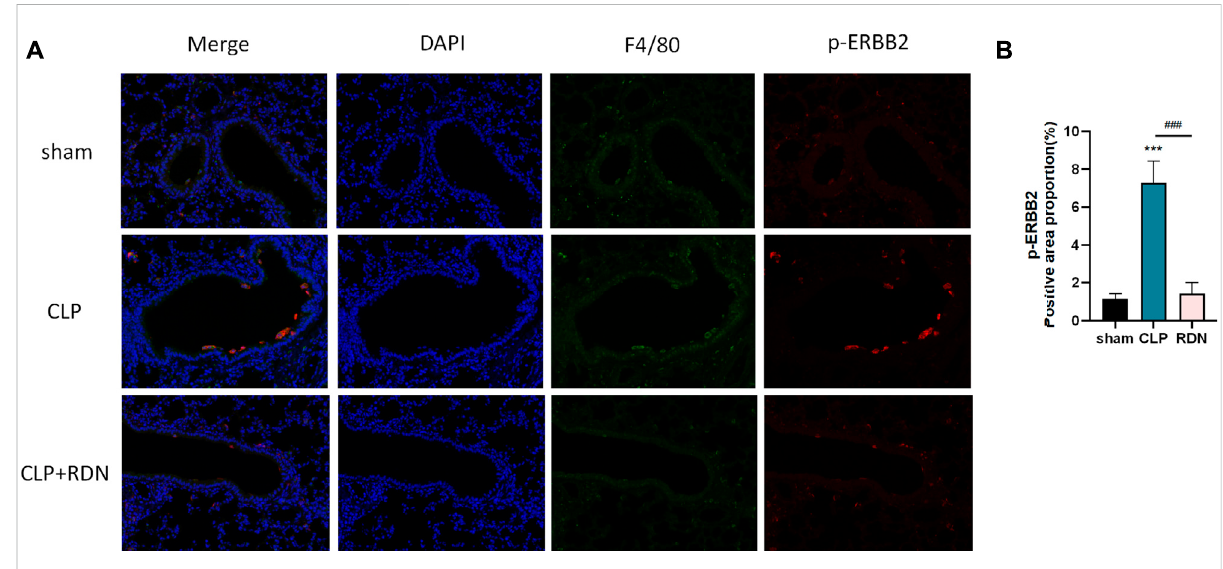
FIGURE 7 Interaction between ERBB2 activation and AMs; (A) IF was applied to detect the macrophage biomarker (F4/80) and the activation forum of ERBB2 (p-ERBB2). (B) Reduning could reduce the expression level of p-ERBB2 enhanced in the CLP group. *** p < 0.005 and ### p < 0.005. The asterisk (*) represents statistically signi fi cant difference between the indicated group and the Con